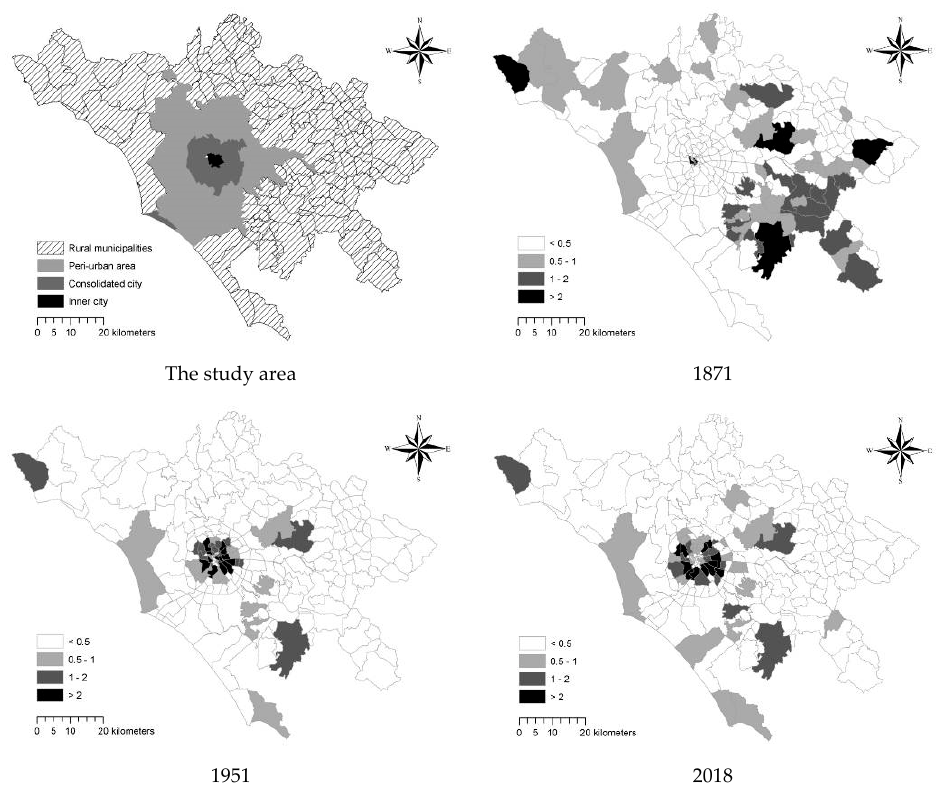
Figure 2. Spatial distribution of resident population (percent share of population residing in each spatial unit in total population of Rome's metropolitan area) by year.